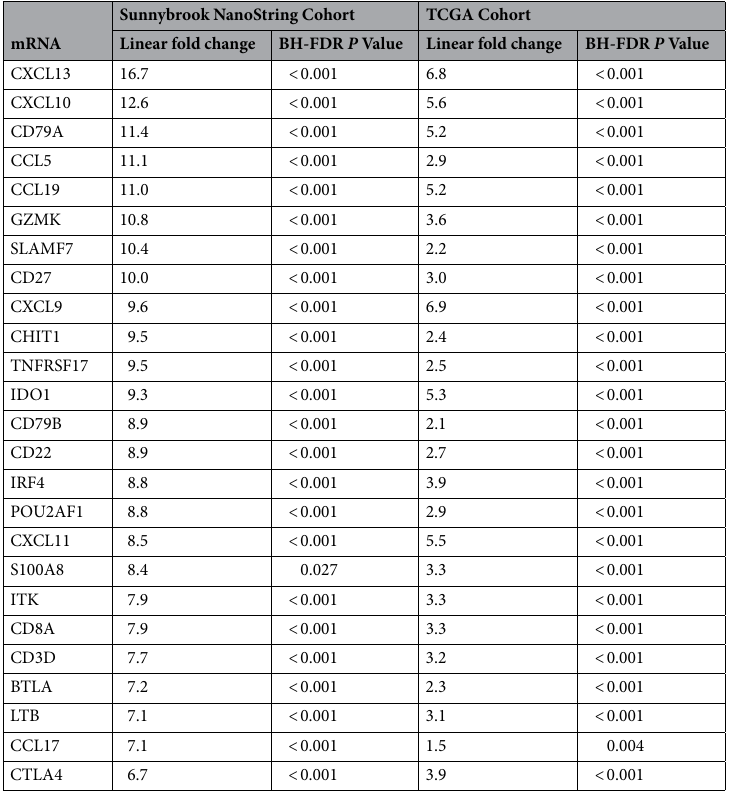
Table 2. Top 25 differentially expressed genes in high- versus low- inflammation muscle invasive urothelial carcinomas in Sunnybrook NanoString cohort and their differential expression between carcinomas with- versus without- immune infiltrates in the TCGA cohort. BH-FDR, Benjamini–Hochberg procedure to decreases the false discovery rate; TCGA, The Cancer Genome Atlas.